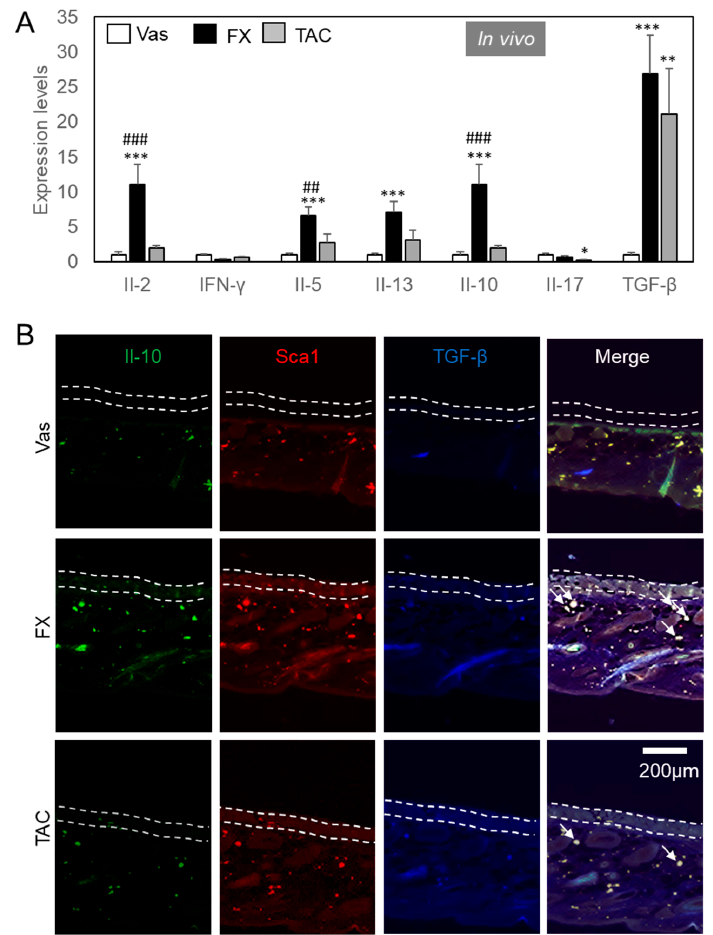
Figure 4. FX stimulated Il-10 + TGF- β + Sca1 + ILCreg. ( A ) Cytokine expression levels regulated by FX or TAC. Samples used in Figure 3 were analyzed using specific primer pairs. Values are means ± SEM. * p < 0.05, ** p < 0.01, *** p < 0.005 vs Vas, ## p < 0.01, ### p < 0.005 vs TAC. ( B ) Il-10 + TGF- β + Sca1 + ILCreg dominantly expressed in FX-treated Nc / Nga mice. Sections were reacted with Alexa Fluor 488 ® anti-mouse Il-10, Brilliant Violet 421 ™ anti-mouse TGF- β 1, and PE anti-mouse Sca1 antibodies. All antibodies were used at a 1:500 dilution. The area between the dot lines indicates the epidermal layer. Arrows indicate typical triple-positive